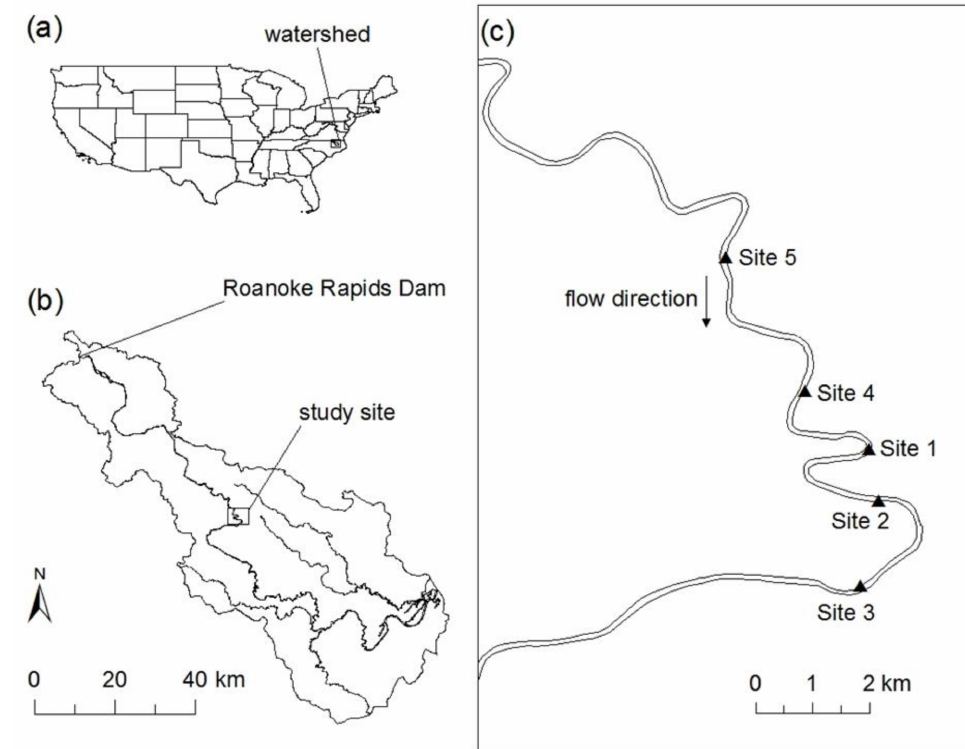
Figure 1. Location of the study area. ( a ) the United States and the lower Roanoke River watershed in NC, ( b ) the Roanoke River watershed below the Roanoke Rapids Dam, and ( c ) the study sites on the lower Roanoke River.